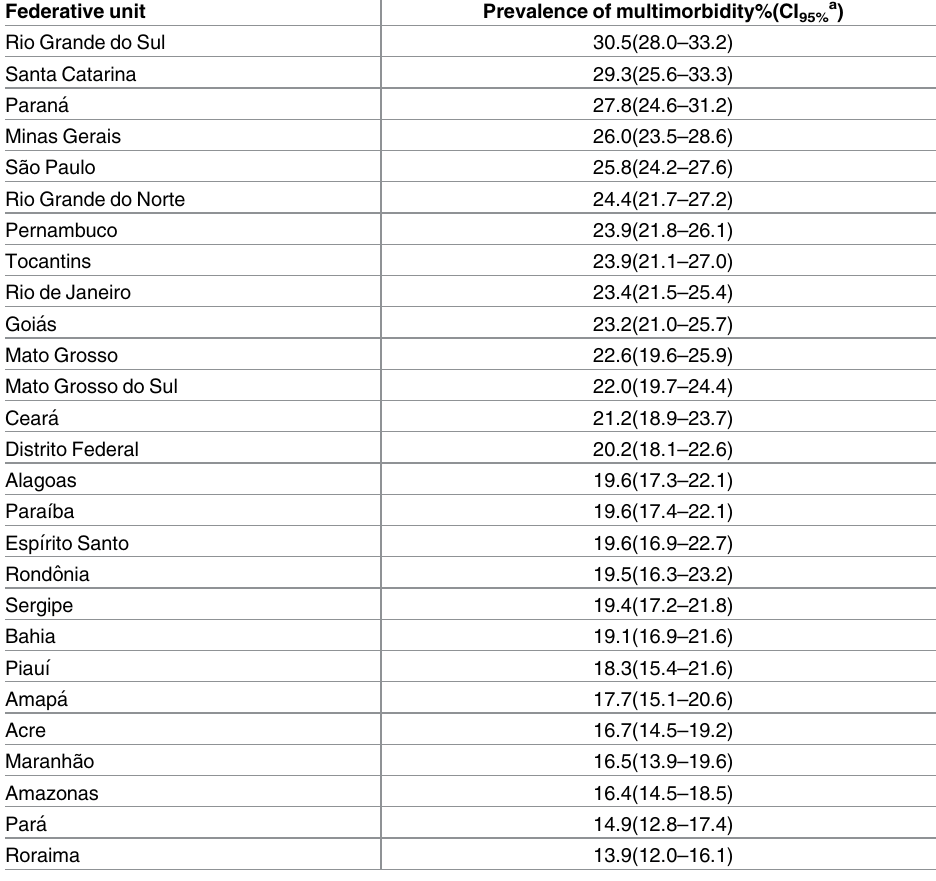
Table 5. Prevalence of multimorbidity among individuals over 18 years of age, per federative unit and federal district. PNS, Brasil, 2013. Federative